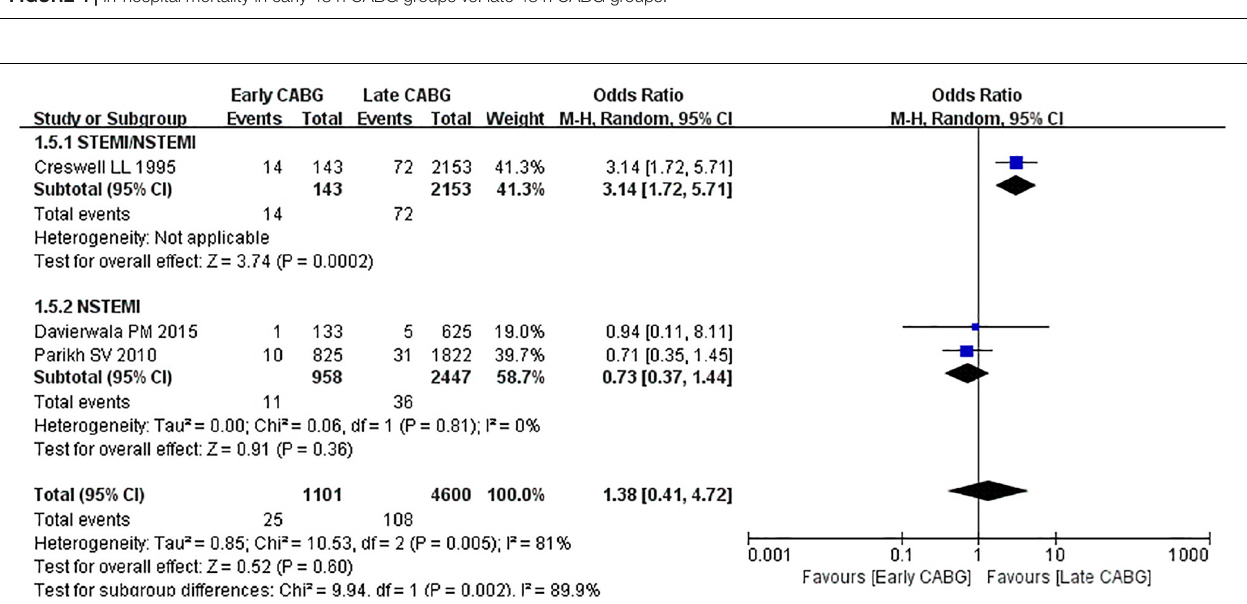
ischemia, delayed surgery should be considered (8, 11, 16,